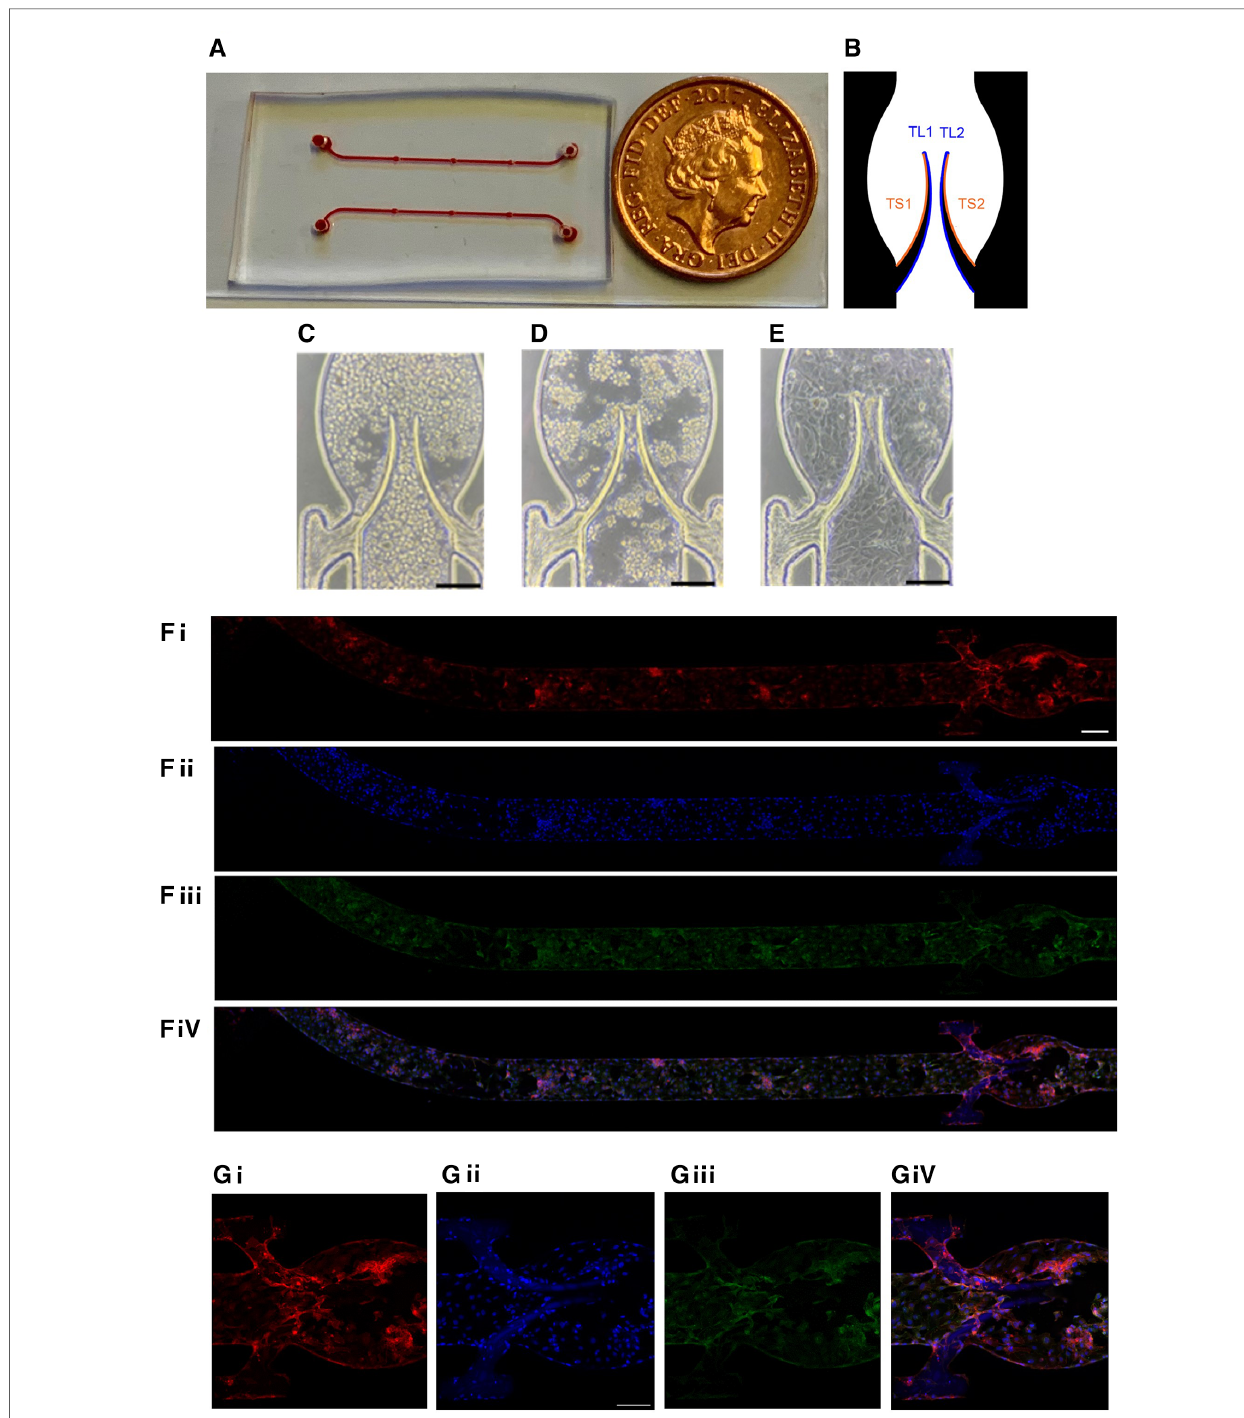
FIGURE 1 Chamber coated with endothelial monolayer. ( A ) General view of the device. ( B ) Subdivision of the valve into four areas (2 for each lea fl et) for quantitation. HUVEC cells were seeded in the fl ow chamber ( C ) and incubated for 4 h without fl ow ( D ) followed by 20 h under fl ow (1 µl/min; E, bar 150 µm). Representative images of the entire chamber ( F ) or the valve area ( G ) stained for CD31 ( Fi,Gi ), nuclei (DAPI, Fii,Gii ), VE-cadherin ( Fiii,Giii ) and merge ( Fiv,Giv ). Scale bar 200 and 150 µm of F and G ,